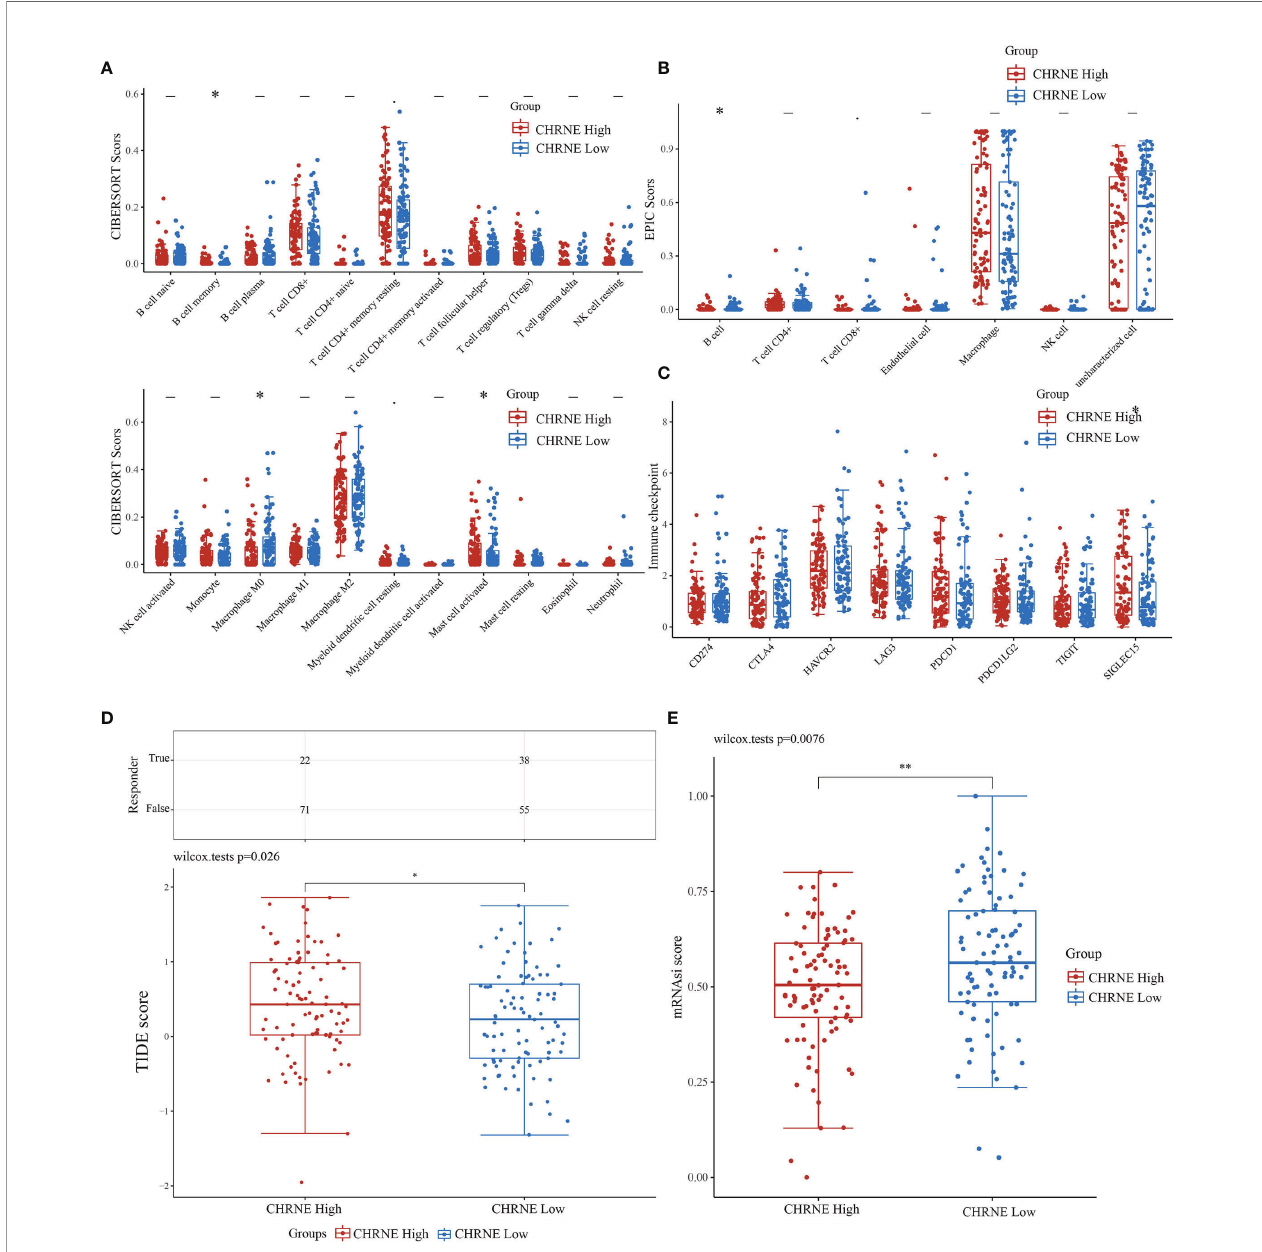
FIGURE 7 | Comparisons of immune status and stemness between CHRNE high expression group and low expression group. (A, B) Comparison of CHRNE high expression group and CHRNE low expression group in immune in fi ltration obtained with CIBERSORT and EPIC algorithm; The horizontal axis represents different immune cells, the vertical axis represents the immune scores (*P<0.05, **P<0.01). (C) Comparison immune checkpoint genes expression in CHRNE high expression group and CHRNE low expression group; The horizontal axis represents different immune checkpoint genes, the vertical axis represents the expression level (*P<0.05). (D) Statistical table of immune response and the distribution of immune response scores of the different groups in predict results. (*P<0.05) (E) Comparison of CHRNE high expression group and CHRNE low expression group in stemness was exhibited by mRNAsi score with OCLR algorithm.